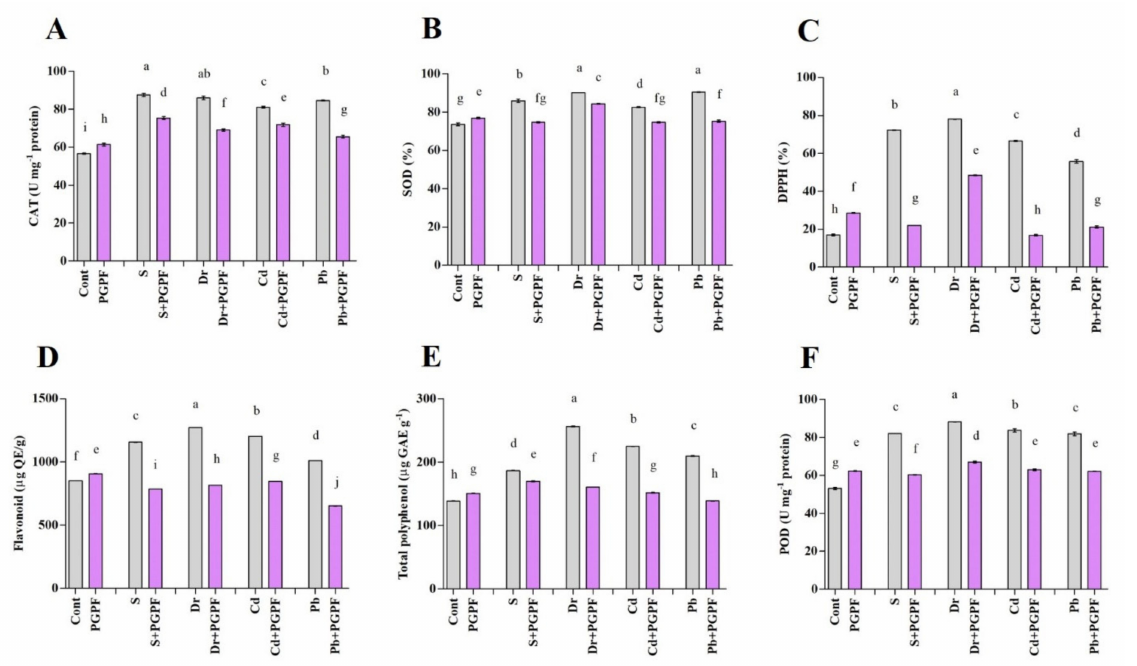
Figure 9. Antioxidant contents (( A ) CAT (Catalase), ( B ) SOD (Superoxide dismutase), ( C ) DPPH (2,2-diphenyl-1-picrylhydrazyl), ( D ) Flavonoids, ( E ) Total polyphenol and ( F ) POD (Peroxidase)) in leaves of tomato plants grown under normal and stress conditions and inoculated with PGPF for 10 days. Treatments: Cont (control), PGPF ( Cunninghamella bertholletiae ), S (1.5% sodium chloride), S (1.5% sodium chloride) + PGPF ( Cunninghamella bertholletiae ), Dr (25% polyethylene glycol), Dr (25% polyethylene glycol) + PGPF ( Cunninghamella bertholletiae ), Cd (3 mM cadmium), Cd (3 mM cadmium) + PGPF ( Cunninghamella bertholletiae ), Pb (3 mM lead), and Pb (3 mM lead) + PGPF ( Cunninghamella bertholletiae ). Values are shown as the means ± SD ( n = 5) and significant differences at p < 0.05 (Tukey test) are indicated by different lowercase letters above the